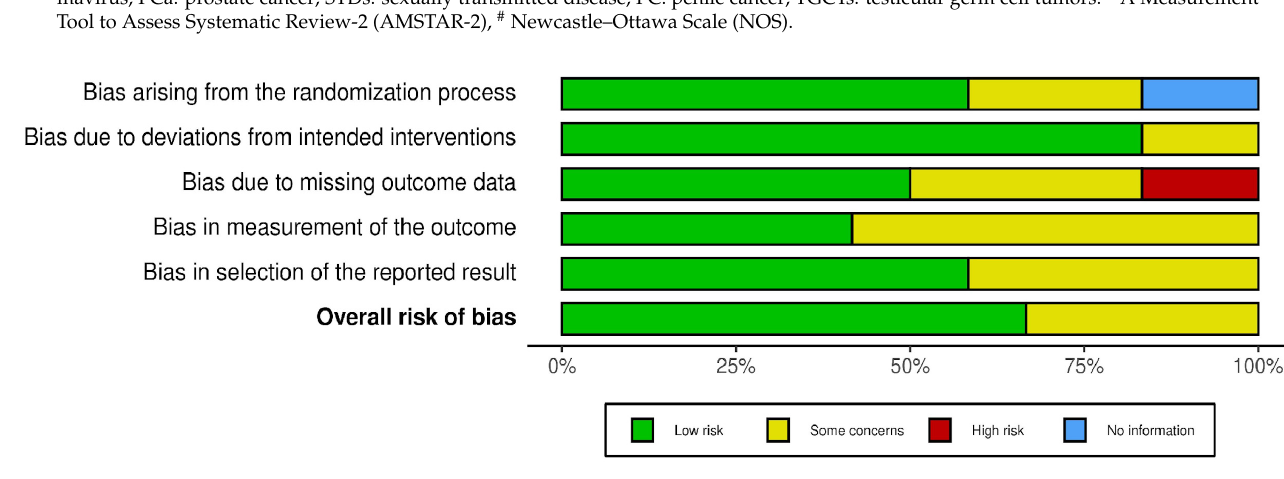
Figure 3. Risk of bias domains. 3.1. Prostate Cancer (PCa) PCa is one of the most diagnosed cancers globally, with an estimated incidence of 1,276,000 new cancer cases and 359,000 deaths in 2018. Several risk factors have been es- tablished (e.g., old age, family history, and African American ethnicity) [31–33]. PCa is the neoplasia that has the greatest impact on the male population and is the most frequently